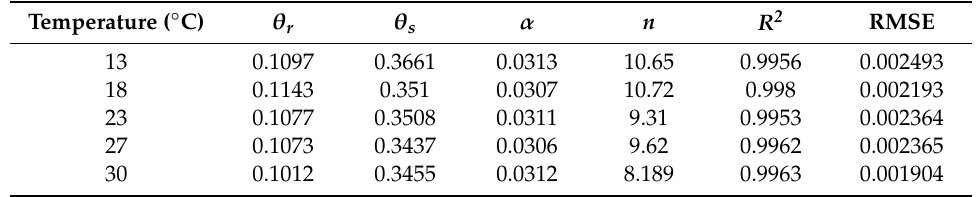
Table 1. Fitting parameters of soil-water characteristic curves (SWCC) at different temperatures from the soil column experiment.